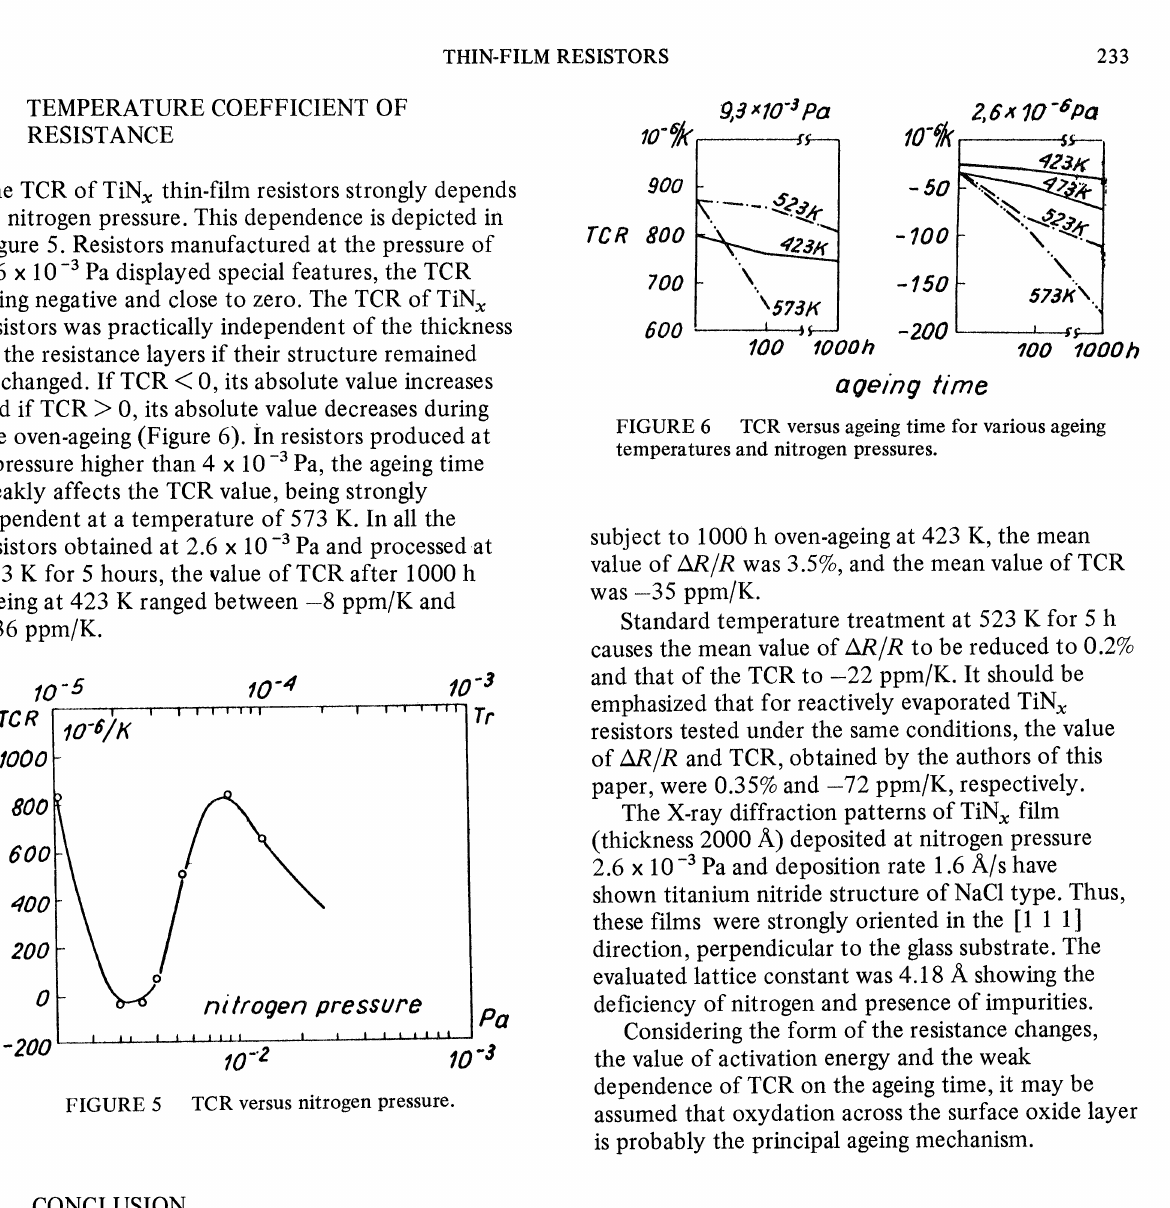
FIGURE 5 TCR versus nitrogen pressure.